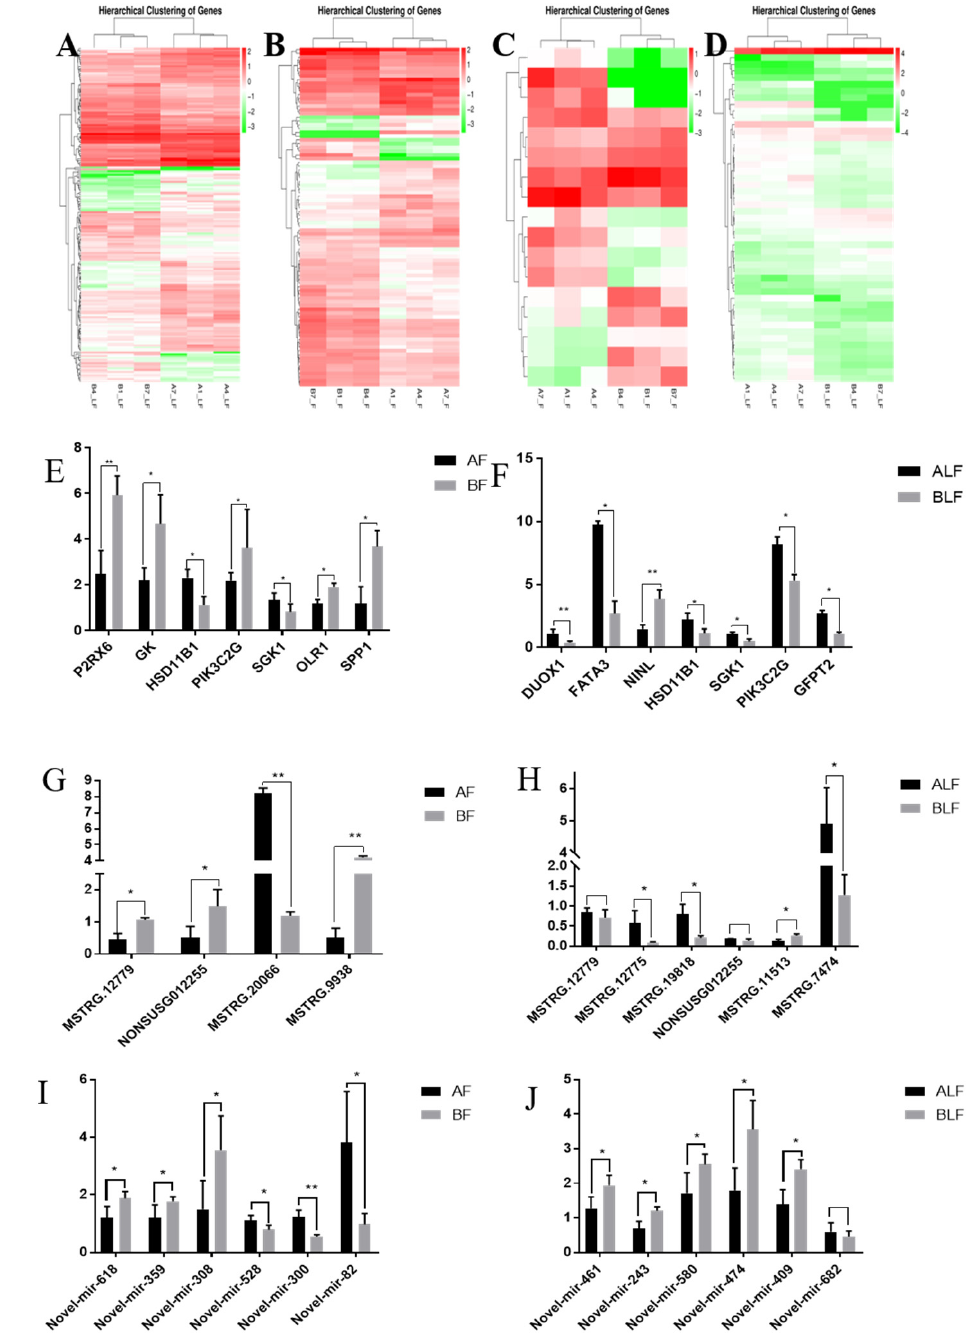
Figure 2. Hierarchical clustering analysis was performed based on the FPKM values of differentially expressed genes under different experimental conditions. ( A ). Cluster analysis of gene levels in castrated and intact pig backfat tissues. ( B ). Cluster analysis of gene levels in castrated and intact pig abdominal tissues. ( C ). Cluster analysis of lncRNA levels in castrated and intact pig backfat tissues. ( D ). Cluster analysis of lncRNA levels in castrated and intact pig abdominal tissues. Quantitative PCR validation. Differentially expressed genes ( E , F ), lncRNAs ( G , H ) and miRNAs ( I , J ) were confirmed by quantitative PCR. The results are shown as the means ± standard deviation of triplicate measurements. AF indicates intact backfat, BF indicates castrated backfat, ALF indicates intact abdominal fat, BLF indicates castrated abdominal fat. * indicates p < 0.05, ** indicates p < 0.01.